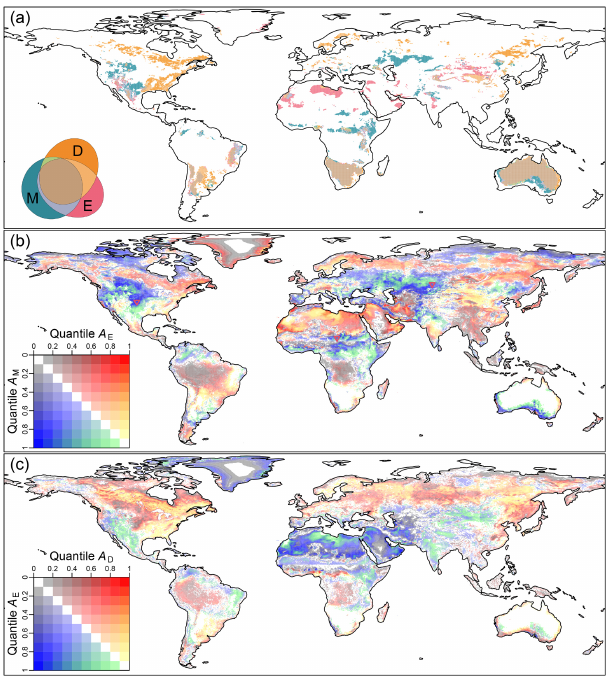
Figure 2. (a) Spatial patterns of significant A M , A E , and A D (top 10% quantile of absolute values) in summer (JJA and DJF for Northern and Southern Hemisphere, respectively). Euler diagrams show the colors for specific relationships (intersections, unions, or disjoints) among A M , A E , and A D , and the areas of colored patterns also correspond to the fractions. (b–c) Quantile changes (b) from A M to A E and (c) from A E to A D in summer. The quantile of the A is separated into 10 bins. The color of the grid cell is ex- plained by the legend, where x and y axes indicate its quantile bins of specific A . The diagram has three aspects of information. First, warm (cold) colors indicate a quantile increase (decrease) from the original A ( y axis) to the final A ( x axis). Second, the smaller the quantile difference is, the more transparent the color. White indi- cates no change of quantile bin. Third, as the shifts in the large quantile bins are the main focus, we highlight this part in green and yellow. For shifts that occur within the low quantile bins, colors fade to gray. Three red triangles are samples from three regions where A is dramatically underestimated by monthly